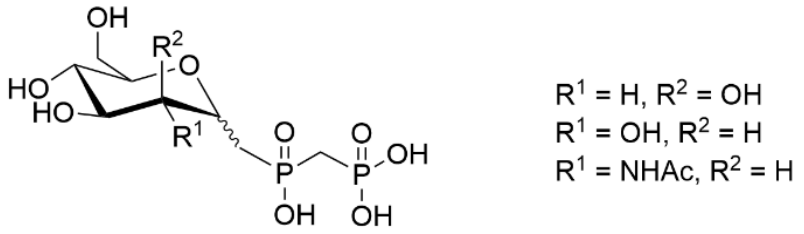
Figure 3. Structure of the targeted compounds .